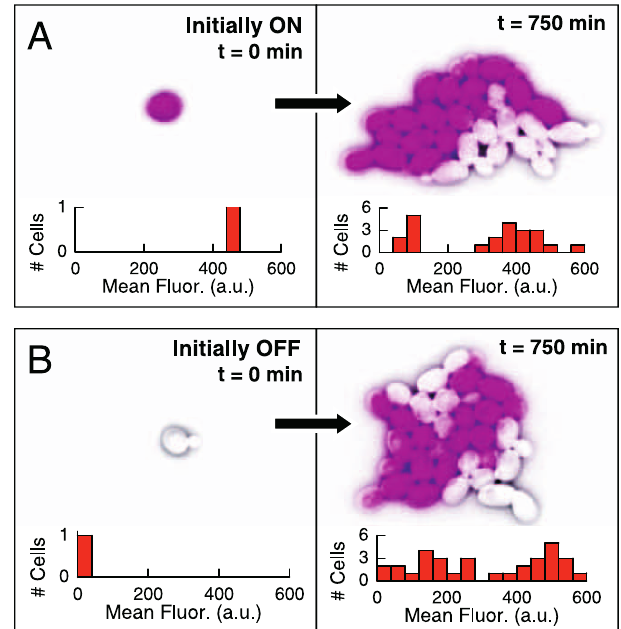
Figure 1. Cells Switch between Expressing and Nonexpressing States Images are phase contrast micrographs (black and white) overlaid with background-subtracted fluorescent signal (purple). (A) Over 750 min, or between 4 and 5 generations, an initially ON cell of strain MA0188 develops into a small variegated colony with subpopu- lations of ON and OFF cells. (B) An initially OFF cell likewise grows into a mixed colony with both ON and OFF cells. The sharp interface between ON and OFF cells in both (A,B) indicates that cell-cell communication does not play a major role in defining cell expression state. a.u., arbitary